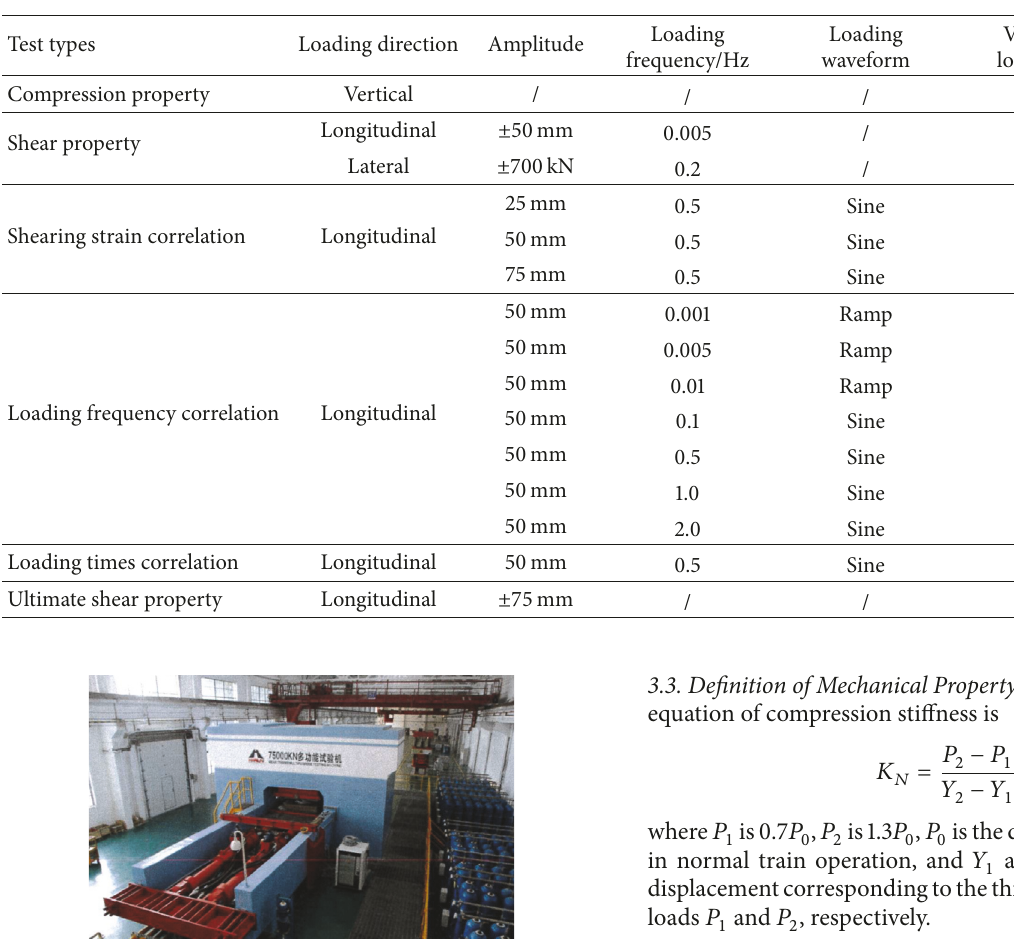
Table 2: Mechanical property test program of novel antivibration bearing.